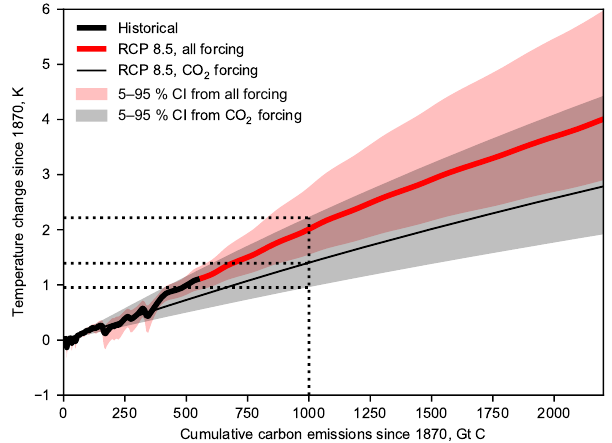
Figure 10. Comparison of earth’s energy imbalance N to observa- tions from Argo and CERES, from Johnson et al.